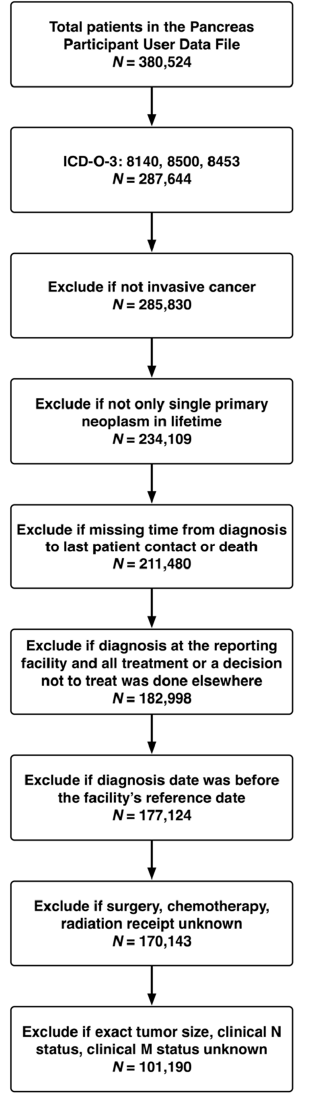
Figure 1. Assembly of analysis cohort.